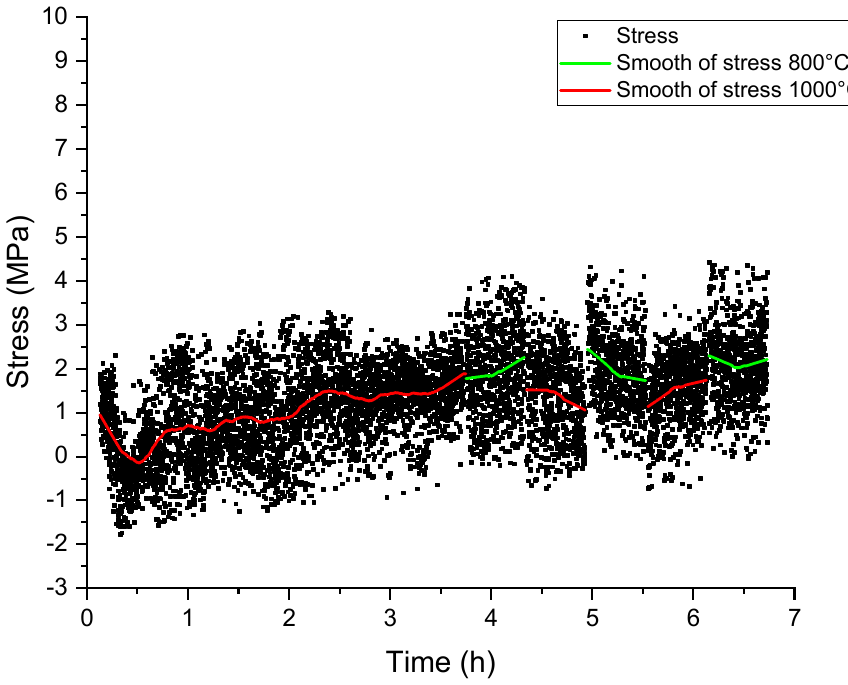
Figure 19. Stress-time curve in metal with the second correction method for R0.58.